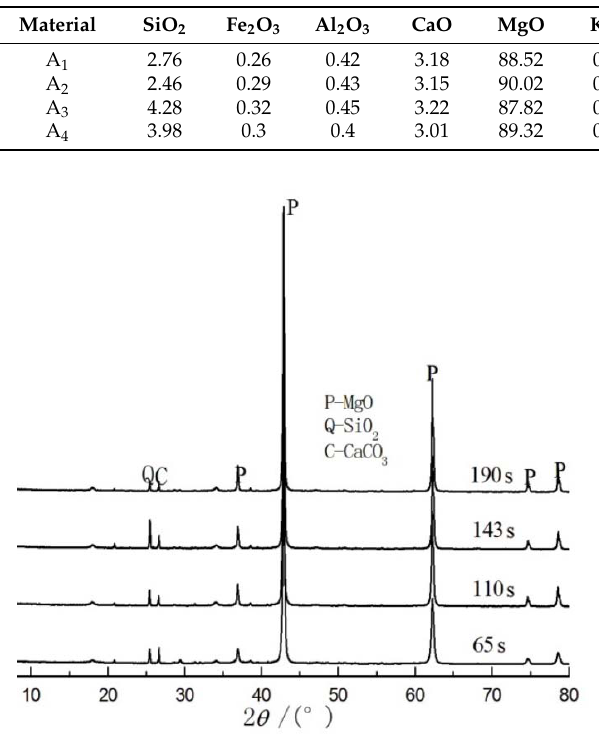
Figure 2. The XRD patterns of four light ‐ burned